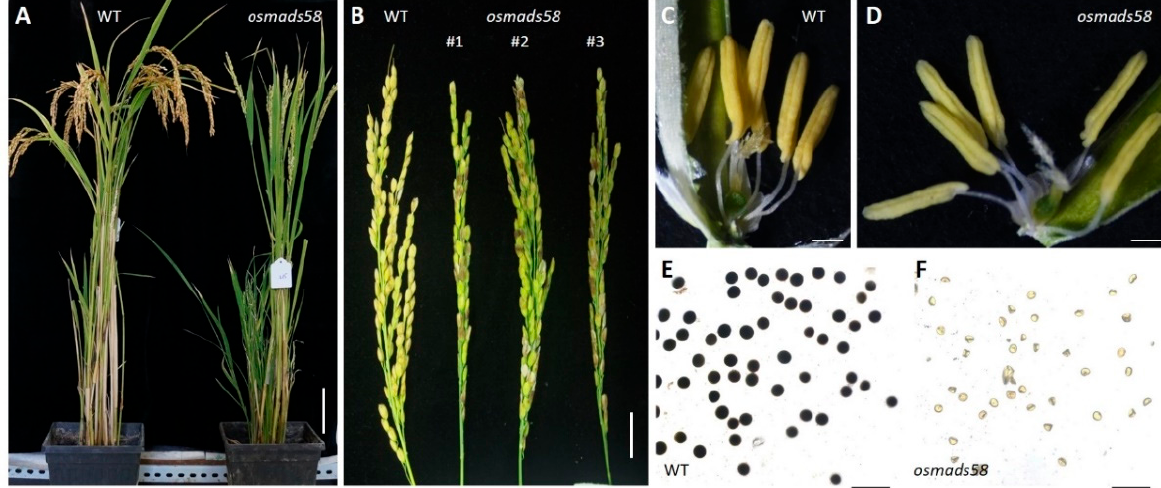
Figure 1. The osmads58 CRISPR lines exhibit male sterility. ( A ) Comparison of wild ‐ type (WT) and osmads58 CRISPR plants after seed maturation. Bars, 10 cm. ( B ) Panicles in wild ‐ type and osmads58 CRISPR plants. Bars, 1 cm. ( C , D ) Stamens in wild ‐ type ( C ) and osmads58 CRISPR ( D ) plants; the wild type had normal yellow stamens, and the mutant appeared slightly yellow. Bars, 500 µ m. ( E , F ) Wild ‐ type ( E ) and osmads58 CRISPR ( F ) pollen grains stained by I 2 ‐ KI solution; osmads58 CRISPR had severe defects in starch accumulation. Bars, 200 μ m.